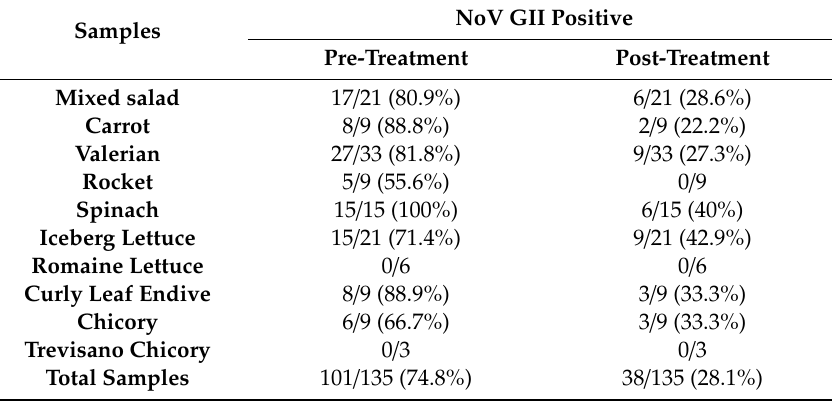
Table 2. Results of NoVs GII RNA detection in ready-to-eat (RTE) salad pre- and post-treatment with PMAxx [50 µ